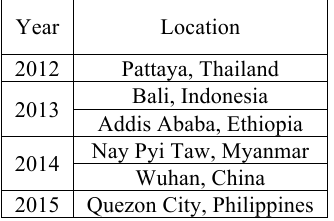
Table 2. Summary of the locations of the last six SC summer schools.